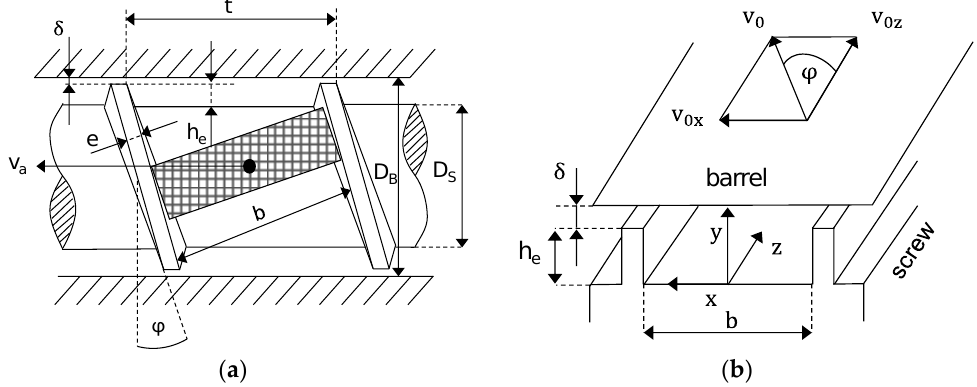
Figure 1. ( a ) Solid element in screw channel; ( b ) unwound channel with coordinate system fixed on screw.